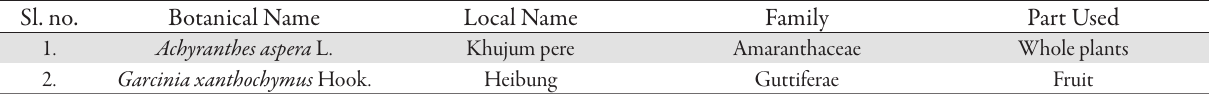
Tab. 2. List of two selected plants used as alkaline and acidic mordants for mineral analysis Sl.